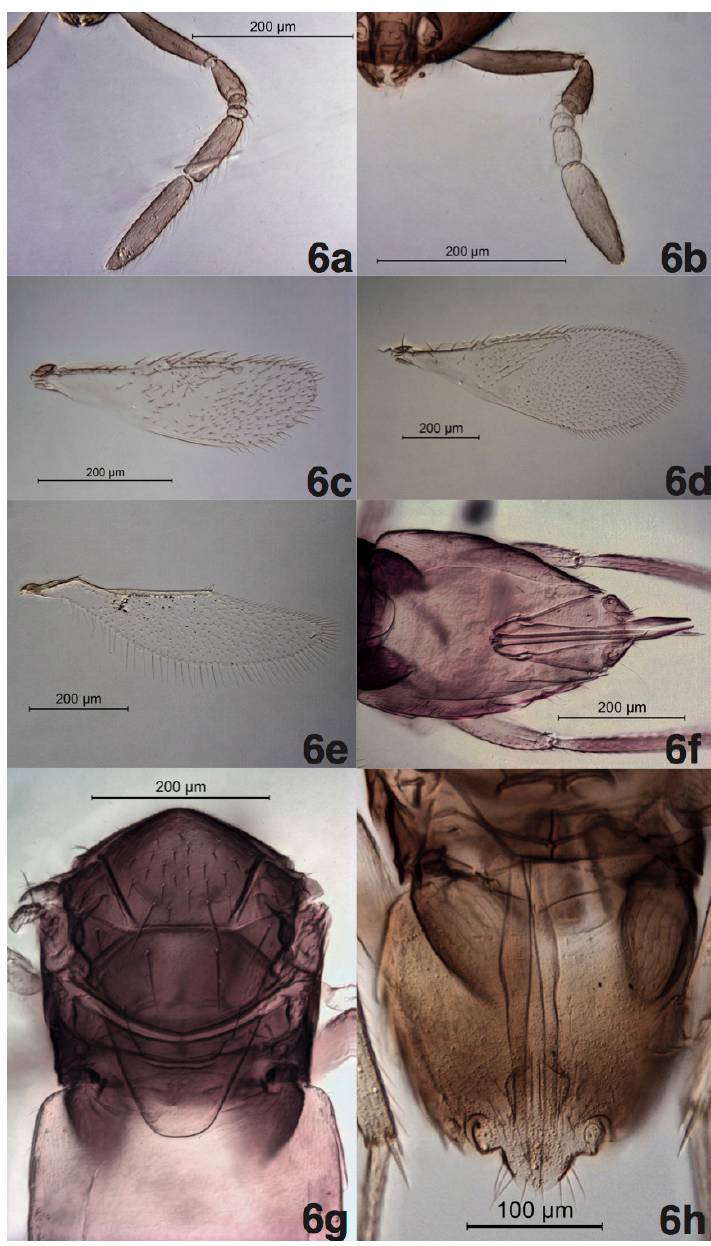
Figure 6. Aphelinus kazakhstanensis , slide-mounted paratypes 6a male, antenna, lateral view (TAMU- ENTO X0856044) 6b female, antenna, lateral view (TAMU-ENTO X0855782) 6c male, fore wing, dorsal view (TAMU-ENTO X0856072) 6d female, fore wing, dorsal view (TAMU-ENTO X0616386) 6e female, hind wing, dorsal view (TAMU-ENTO X0852956) 6f female, metasoma, ventral view (TA- MU-ENTO X0616386) 6g female, mesosoma, dorsal view (TAMU-ENTO X0852880) 6h male, geni- talia, ventral view (TAMU-ENTO